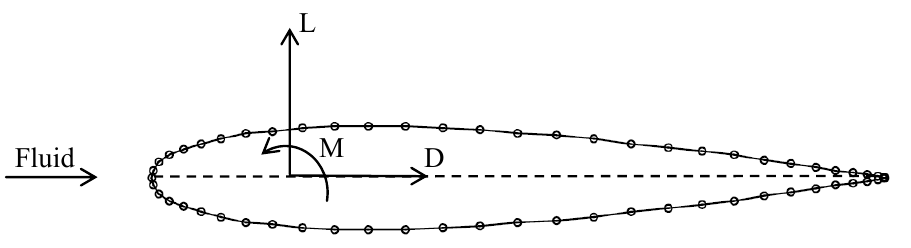
Figure 2. Hydrodynamic forces applied at the pivoting point of a NACA 0014 hydrodynamic